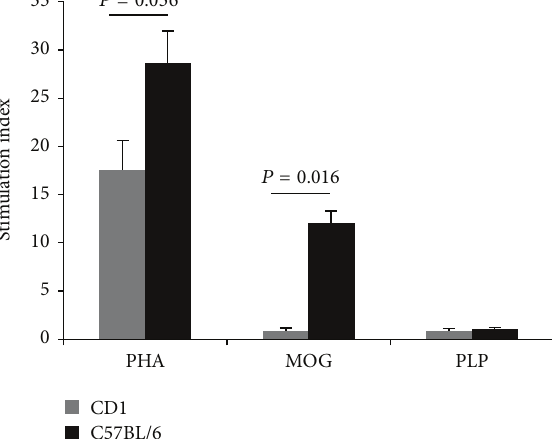
Figure 1: Proliferative capacity of splenocytes from C57BL/6 (susceptible strain) and CD1 (resistant strain) mice. We analyzed proliferative capacity in series of seven mice per condition. Splenocytes from resistant and susceptible mice were stimulated with a polyclonal stimulus (PHA), MOG 35−55 , or PLP 139−151 . Susceptible mice showed a higher proliferative capacity upon PHA stimulation and a statistically significant augmented proliferation upon MOG stimulation. Conversely, splenocytes from both strains did not proliferate when the stimulus used was 139–151 PLP